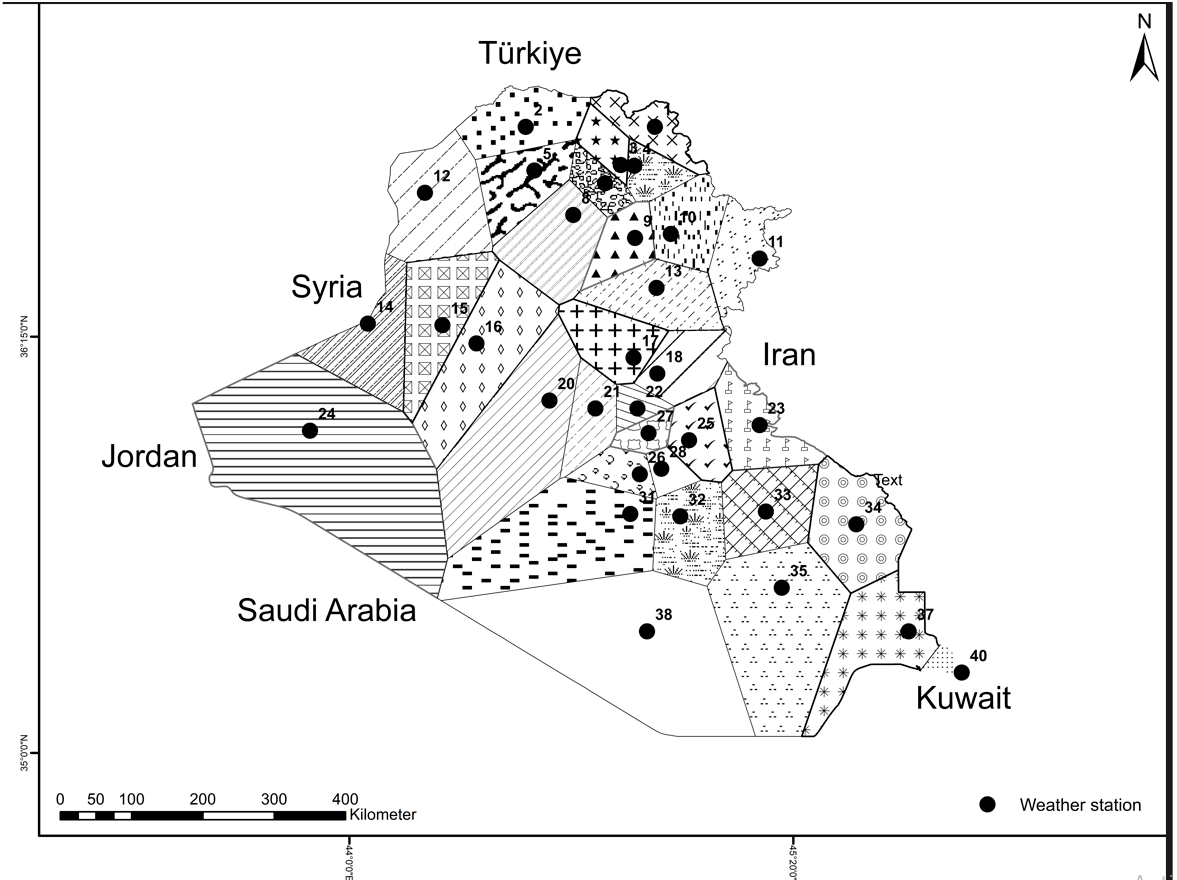
Figure 1. Map of Iraq revealing the locations and associated regions of the meteorological stations.